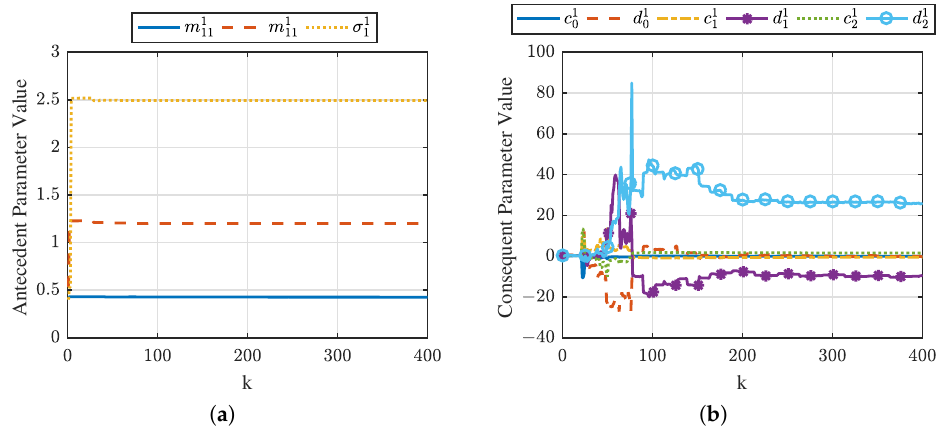
Figure 5. Variations in antecedent and consequent parameters during DHSOIT2FS training. ( a ) An- tecedent parameters. ( b ) Consequent parameters.